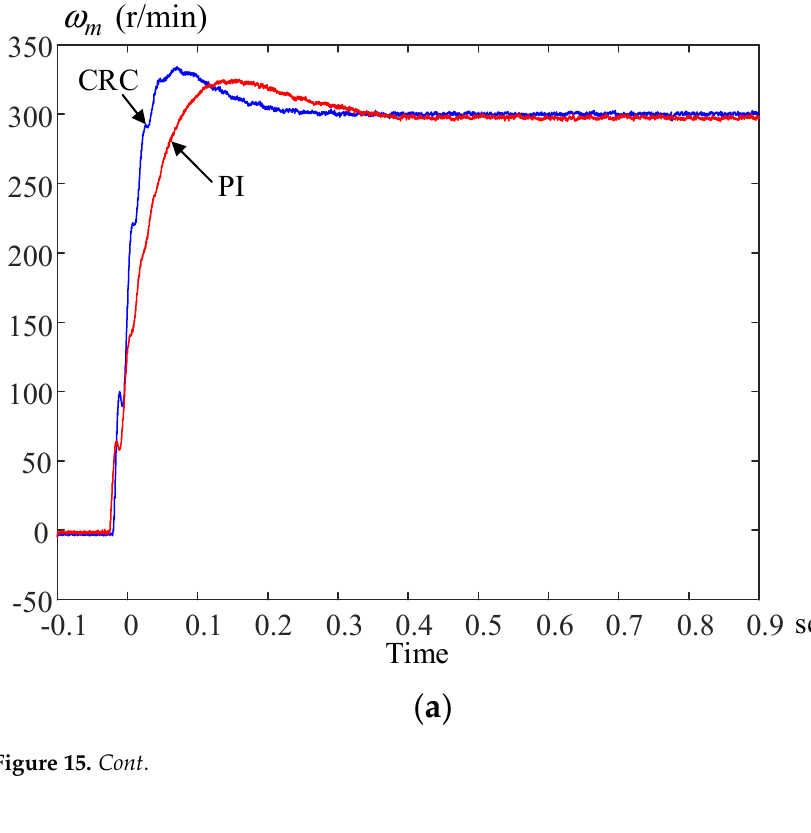
Figure 14. The measured repetitive disturbance responses: ( a ) PI controller; ( b ) CPC.